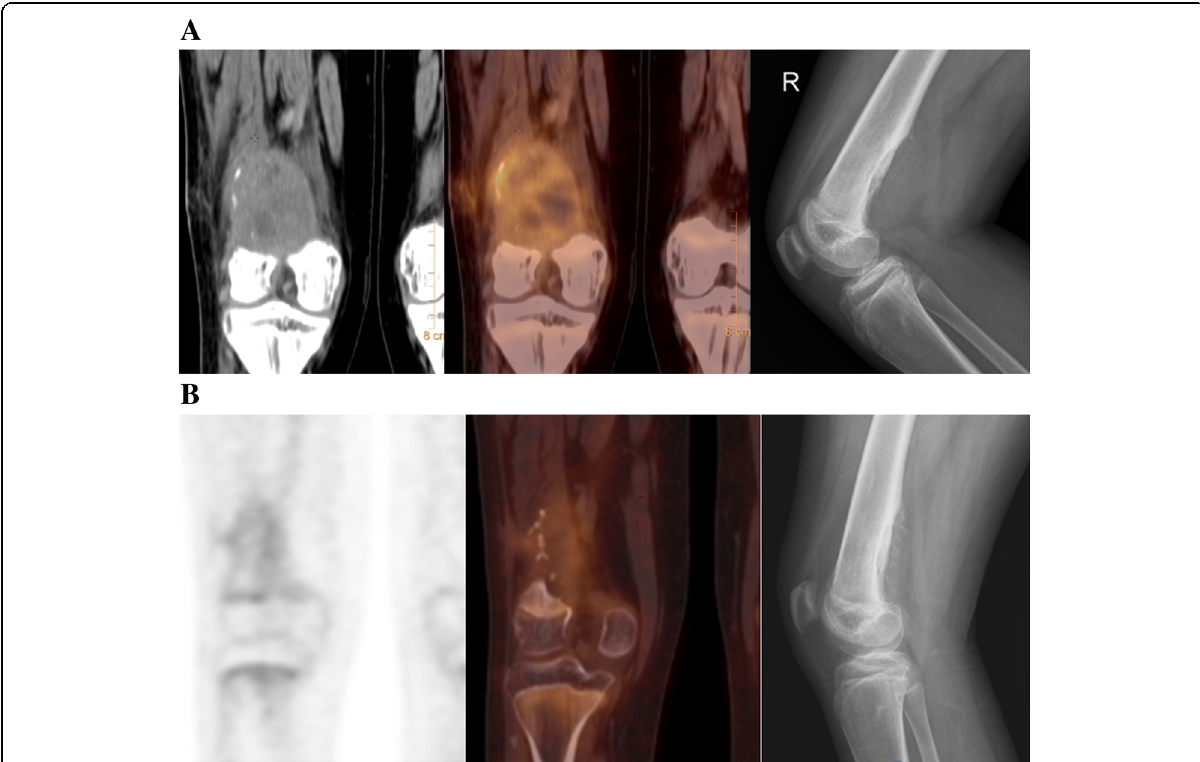
Fig. 2 A 17-year-old male with right femoral Ewing sarcoma. a Prechemotherapy coronal CT (left), PET/CT (middle) showed right femoral metabolically active FDG avid lesion with SUV about 4.7. X-ray (right) revealed posterior distal femoral lesion with a wide zone of transition and aggressive periosteal reaction. b Postchemotherapy coronal PET (left), PET/CT (middle) revealed metabolic regression regarding the distal femoral mass lesion (SUV 2.3). The patient underwent limb salvage surgery and pathological assessment revealed 95% tissue necrosis (good responder). No morphologic changes regarding conventional imaging features